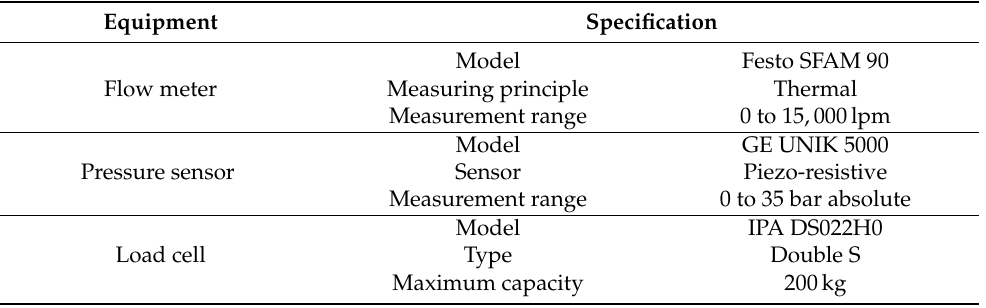
Figure 5. Schematic of experimental setup. Table 4. Specifications of